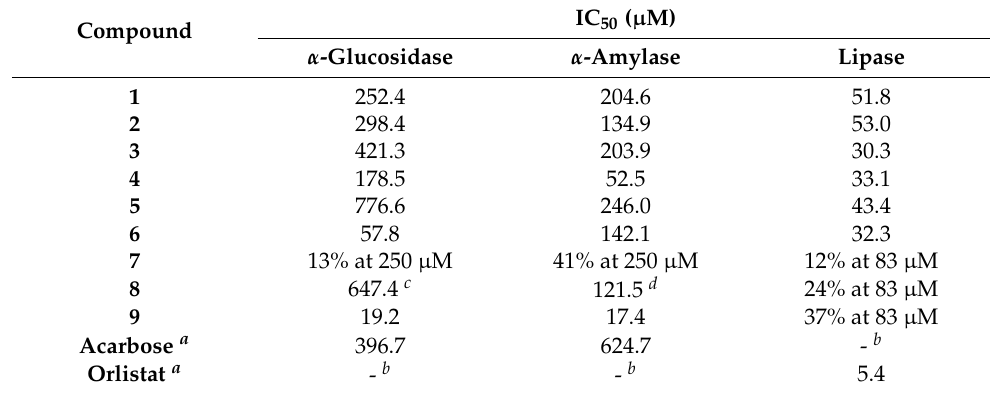
Table 2. α -Glucosidase, α -amylase and lipase inhibition of compounds 1 – 9 . IC 50 ( µ M) Compound α